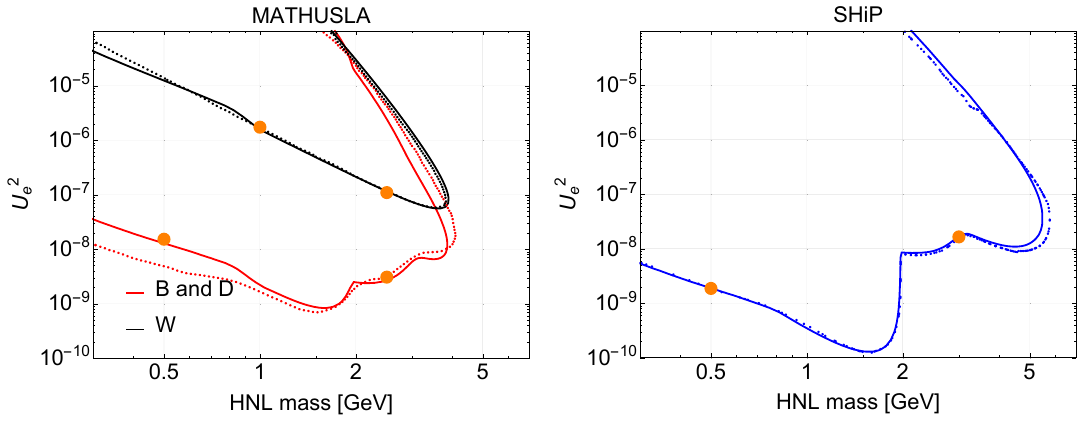
Figure 10 . Comparison of the sensitivities to the HNLs mixing with the electron flavor obtained in this paper (solid lines) with the results of the SHiP [31] and MATHUSLA [19] collaborations y(dotted lines). For the MATHUSLA experiment, the contributions from both B, D mesons and from W bosons are shown separately. For the SHiP experiment, we consider the case of maximally 3 measured mesons, given by the fragmentation fraction f = 2 . 6 10 possible contribution of B − c B c · at LHC energies √ s = 13 TeV [57]. Orange points, based on analytic estimates of the lower boundary, allow for simple cross-check of our results, see appendix G for details. Possible origins of the discrepancy at low masses at the left panel are discussed in appendix